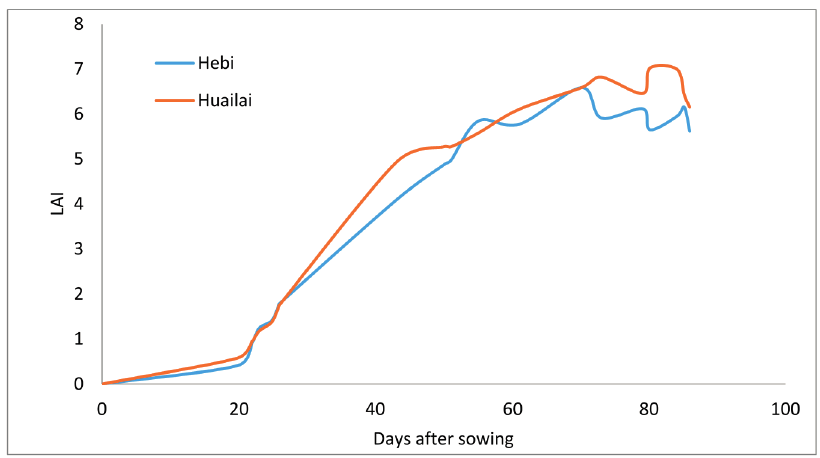
Figure 13. Comparison of wheat LAI change between Hebi and